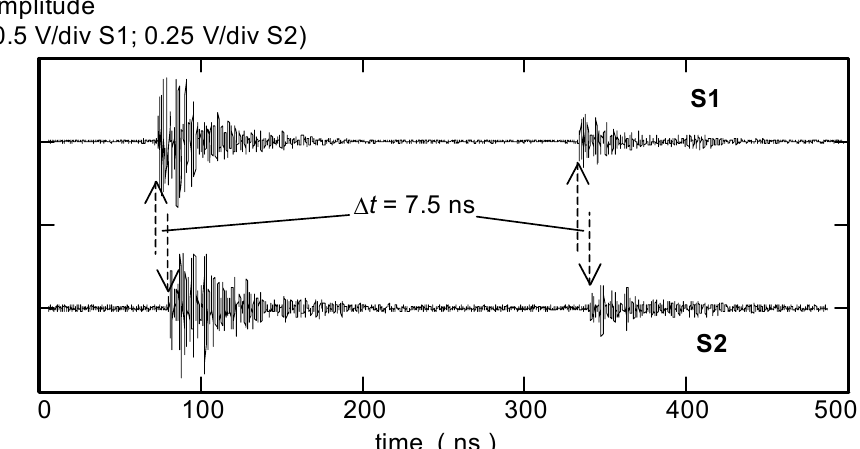
Figure 20. Time-domain signals captured at sensors S1 and S2 simultaneously, showing the UHF responses to a PD pulse at around 100 ns followed by a smaller pulse about 250 ns later.